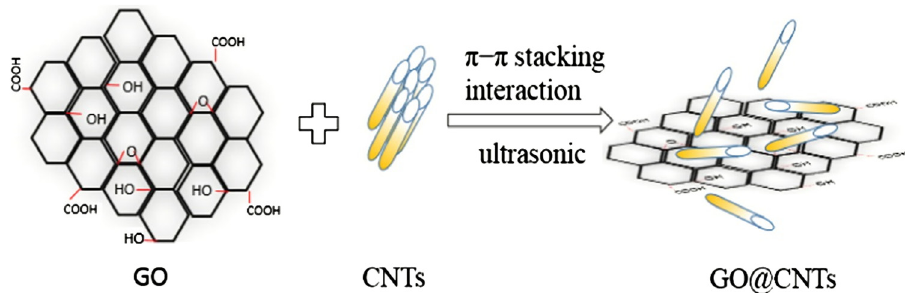
Figure 26: Schematic of dispersion of GO and CNTs [ 149 ] .